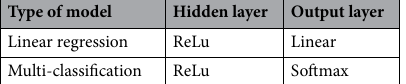
Table 5. Activation function used for the ANN